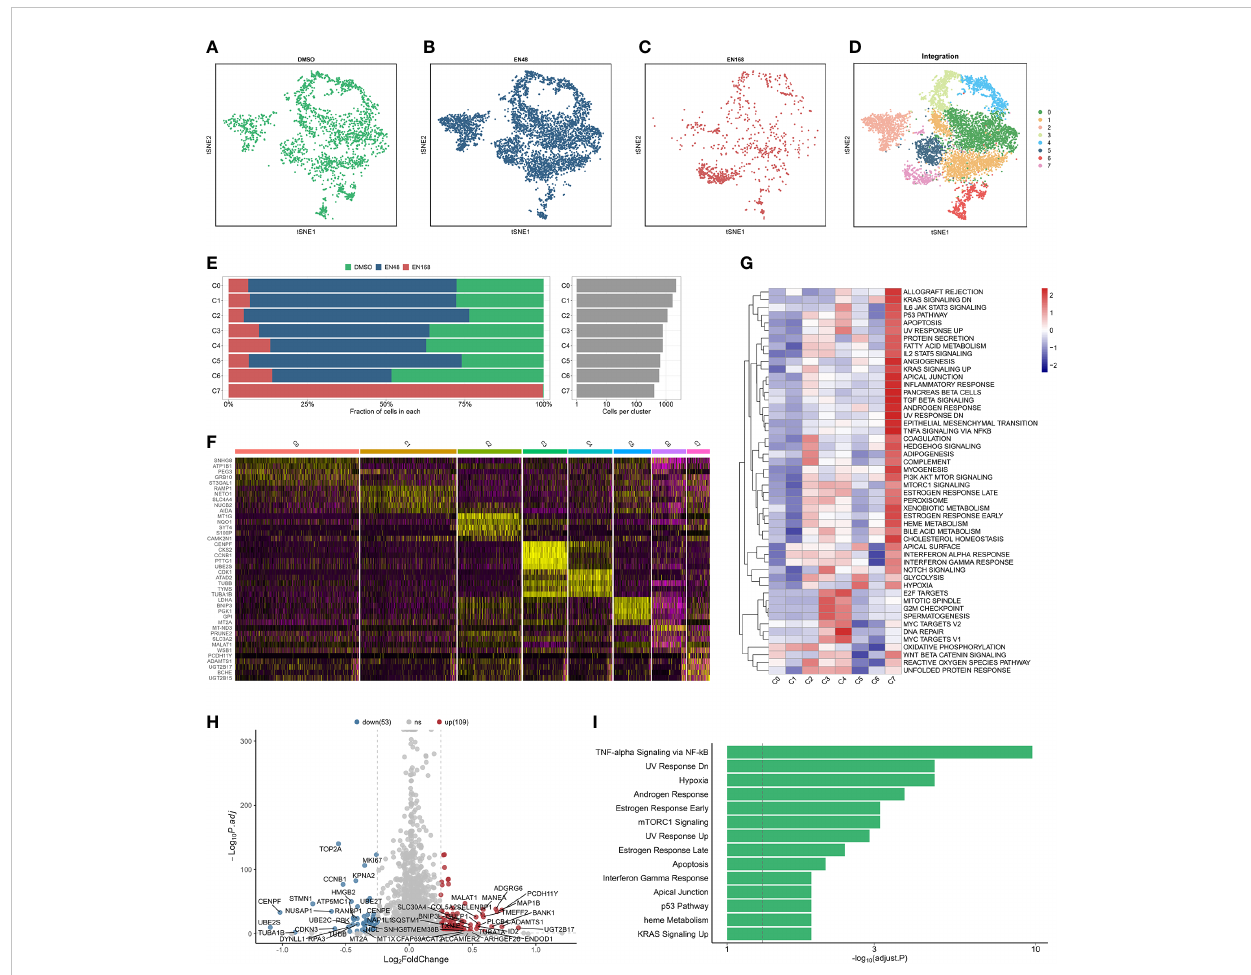
FIGURE 1 The landscape of integrated pro fi ling induced by enzalutamide. The t-distributed stochastic neighbor embedding (tsne) diagram of cells stimulated: DMSO (A) , 48-h enzalutamide (B) , and 168-h enzalutamide (C) . (D) The tsne diagram of integrated analysis induced by enzalutamide in 0, 48, and 168 (H, E) The proportion and number of cells in each cluster. (F) Heatmap for the top fi ve markers in each cluster. (G) Gene set variation analysis in each cluster using Hallmark gene set. (H) volcano plot for the differentially expressed genes (DEGs) between cluster 7 and other clusters. Red dots indicate upregulated genes with log 2 (fold change) > 0.25 and adjusted p-value < 0.05. Blue dots represent downregulated genes with log 2 (fold change) < − 0.25 and adjusted p-value < 0.05. (I) Biological enrichment using the statistically signi fi cant genes from DEGs in cluster 7. Gray vertical dotted line indicates the threshold of adjusted p-value less than